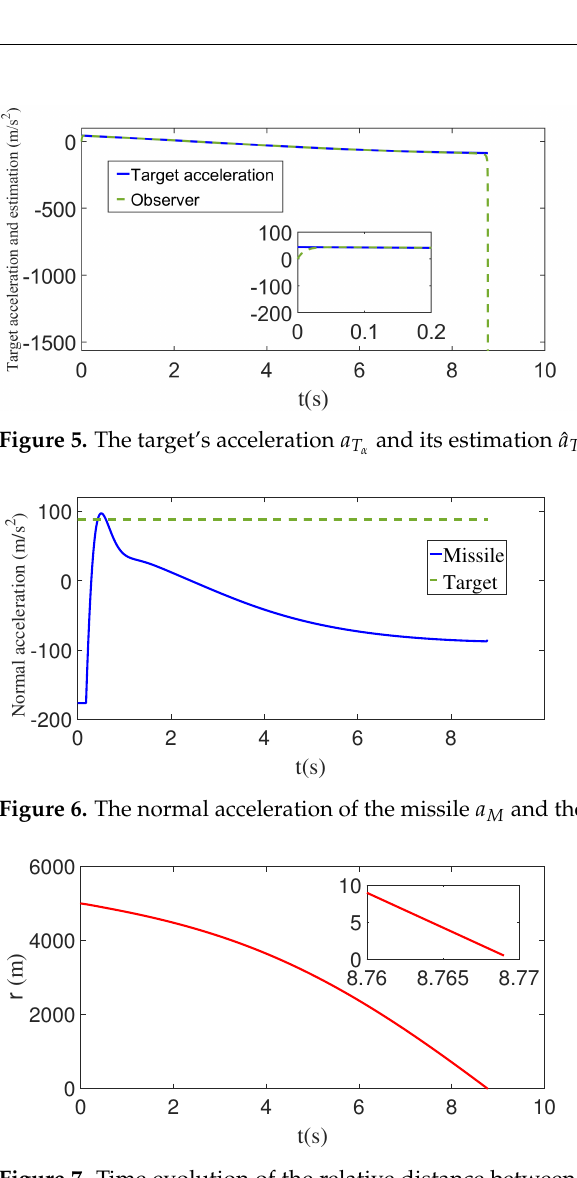
Figure 7. Time evolution of the relative distance between the missile and the target with constant